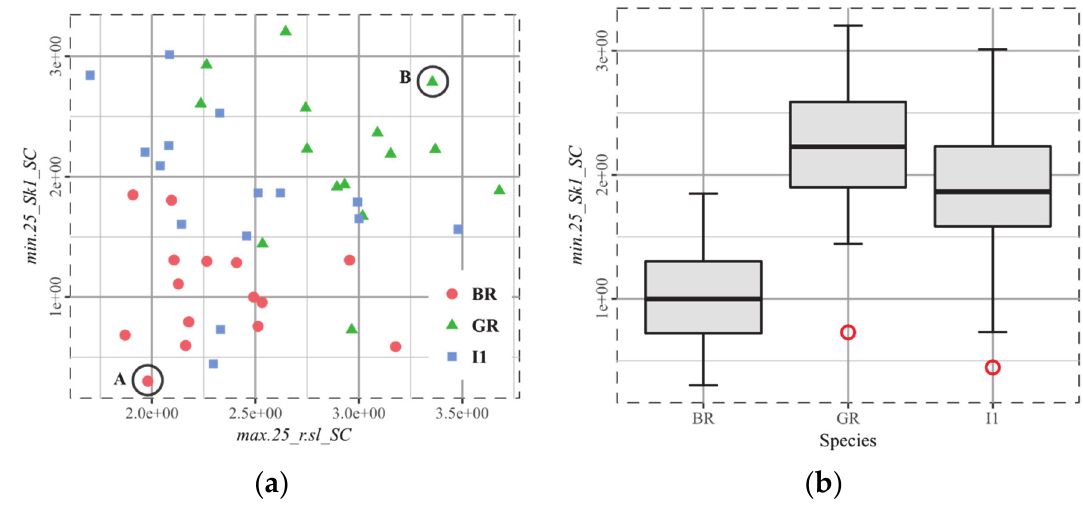
Figure 6 . Red deer, most discriminating parameters. ( a ) The anisotropy parameter r.sl together with the topology parameter Sk1 are able to separate the browsing red deer (BR) from the grazing red deer (GR). The surfaces related to the points (A) and (B) are represented in the ESM; and, ( b ) Here, Sk1 is a browser marker.